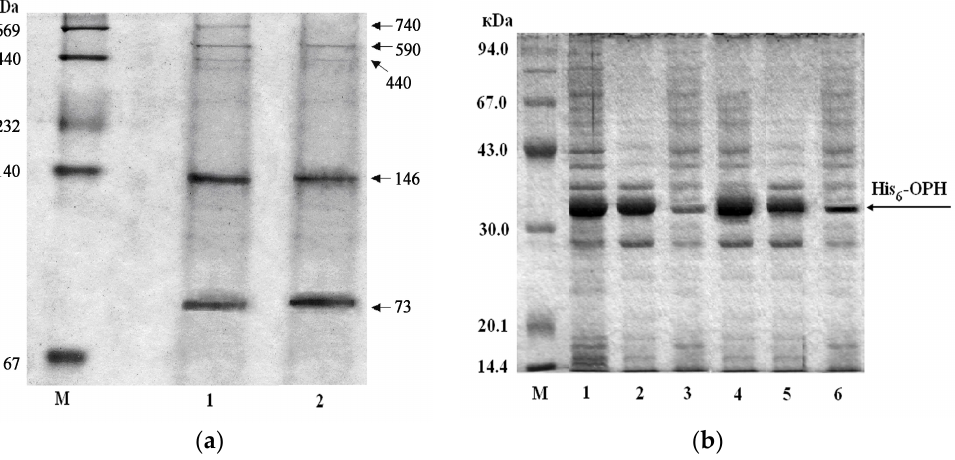
Figure 4. The electrophoregram conducted under non-denaturing ( a ) (1—without PFH addition, 2—with PFH addition) and denaturing ( b ) conditions (1–3 without PFH addition, 4–6 with PFH addition, the 1,4—total protein fractions; 2,5—insoluble protein fractions, 3,6—soluble fraction), reflecting the impact of the presence of PFH in the culture medium on the biosynthesis of OPH. M—markers of molecular weight.